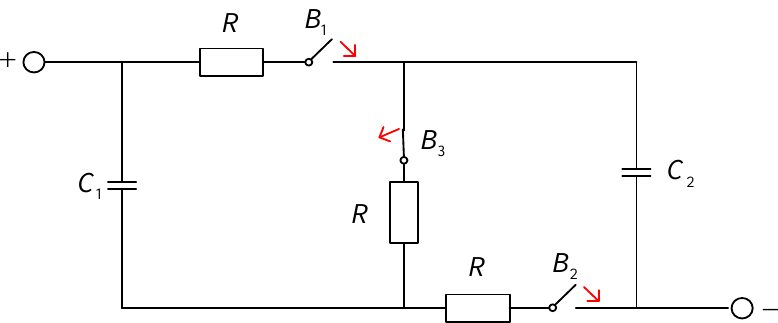
Figure 4. The equivalent circuit of the switching process.